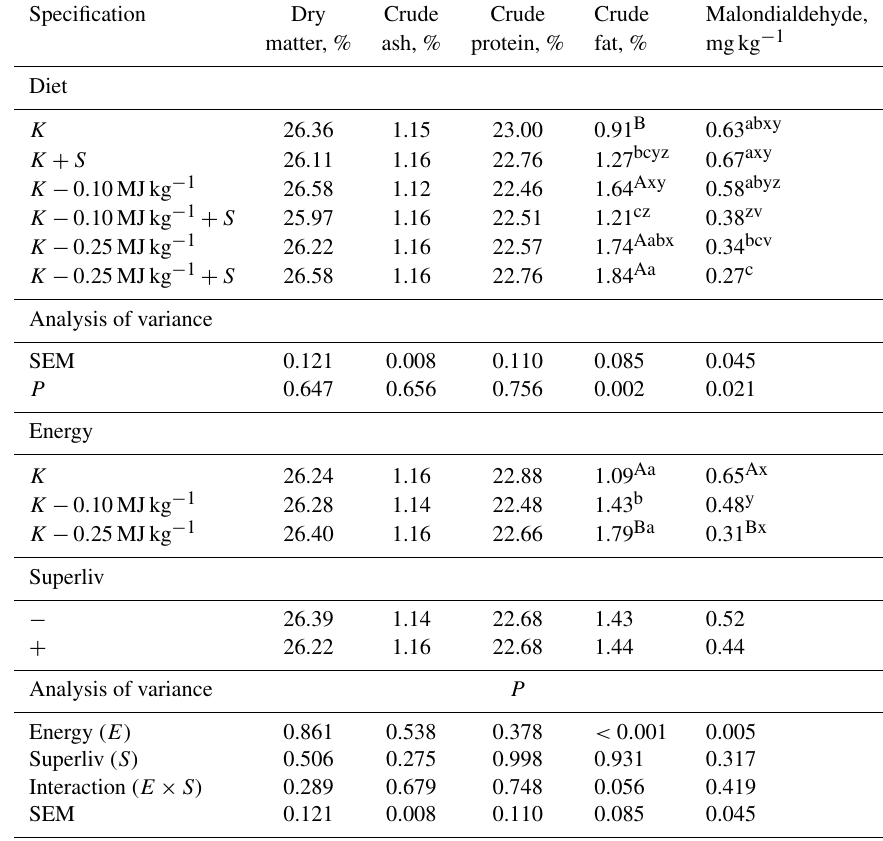
Table 5. Chemical composition of breast muscles.